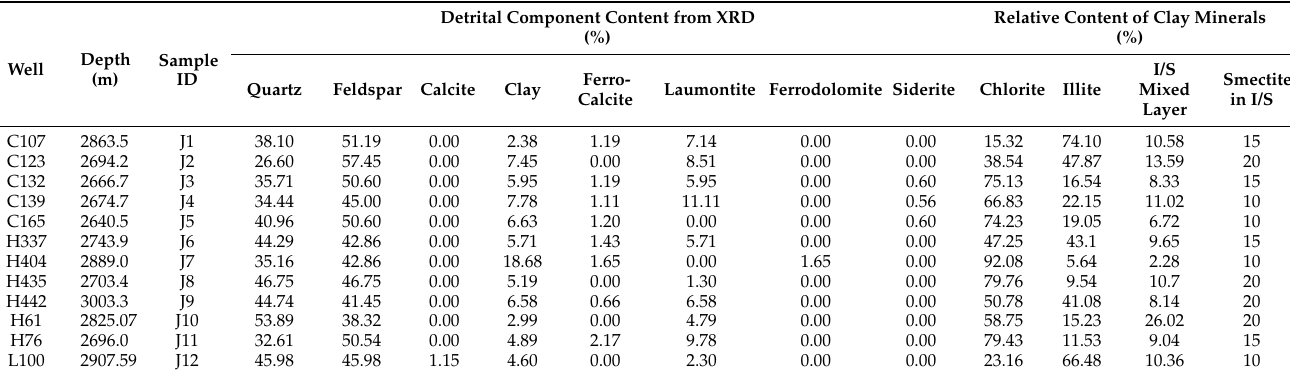
Table 1. Mineral composition and content from the XRD tests for 12